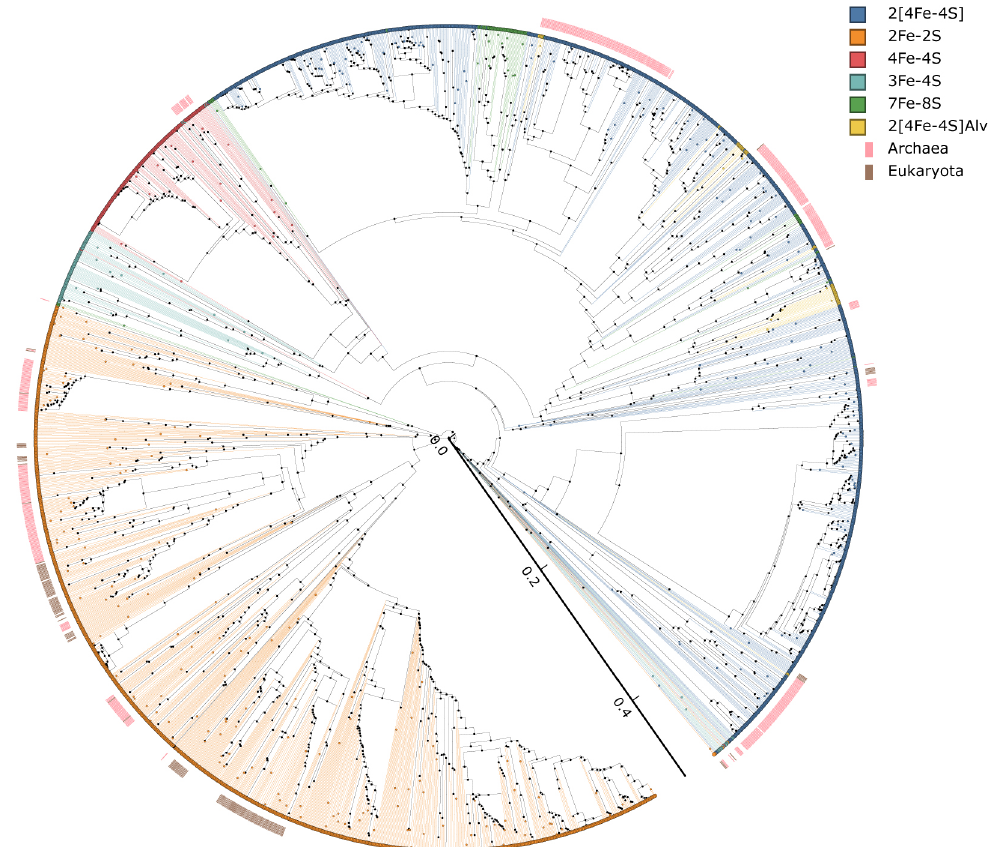
Figure 3. Phylogenetic analysis of ferredoxins. Ferredoxins belonging to different Fe-S cluster types were highlighted in different colors and indicated in the figure. Archaea and Eukaryota ferredoxin sequences were marked with pink and brown stripe, respectively. All other sequences originate from Bacteria. Ferredoxin protein sequences used to construct the phylogenetic tree are presented in Tables S2 and